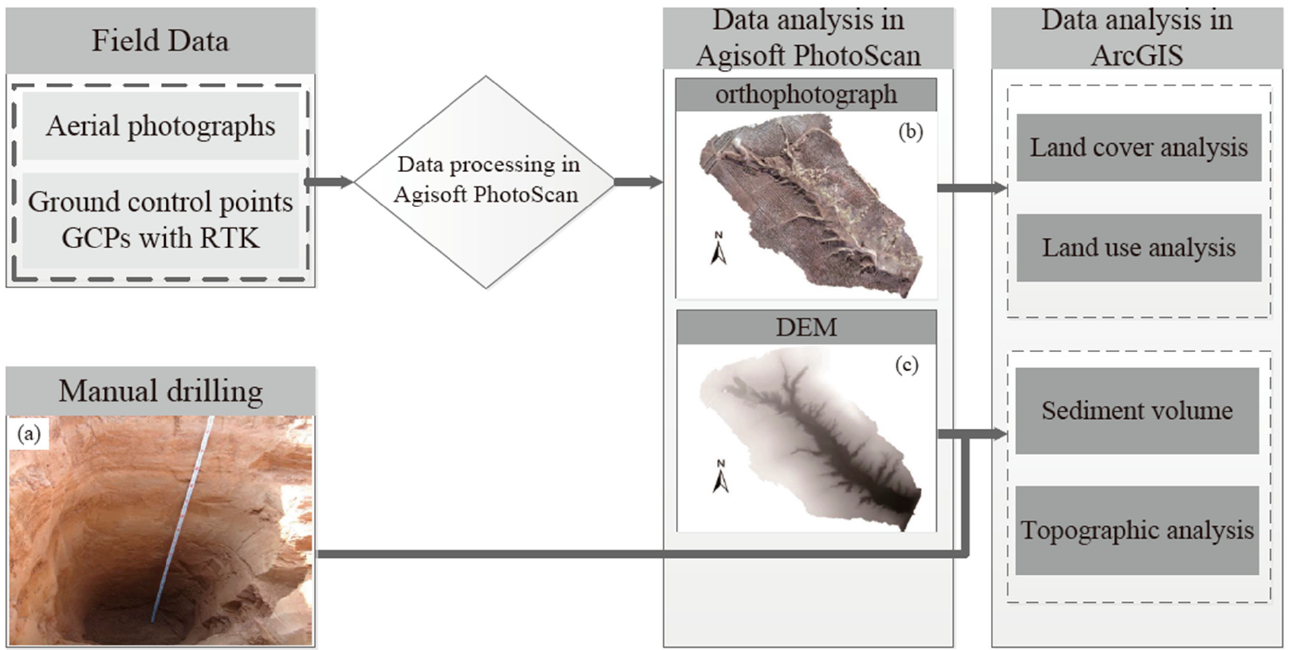
Figure 3. Schematic workflow of processing aerial imagery with Agisoft PhotoScan and ArcGIS. ( a ) Sedimentation profile through manual drilling; ( b ) orthophotograph map; ( c ) DEM of a dam-controlled watershed.